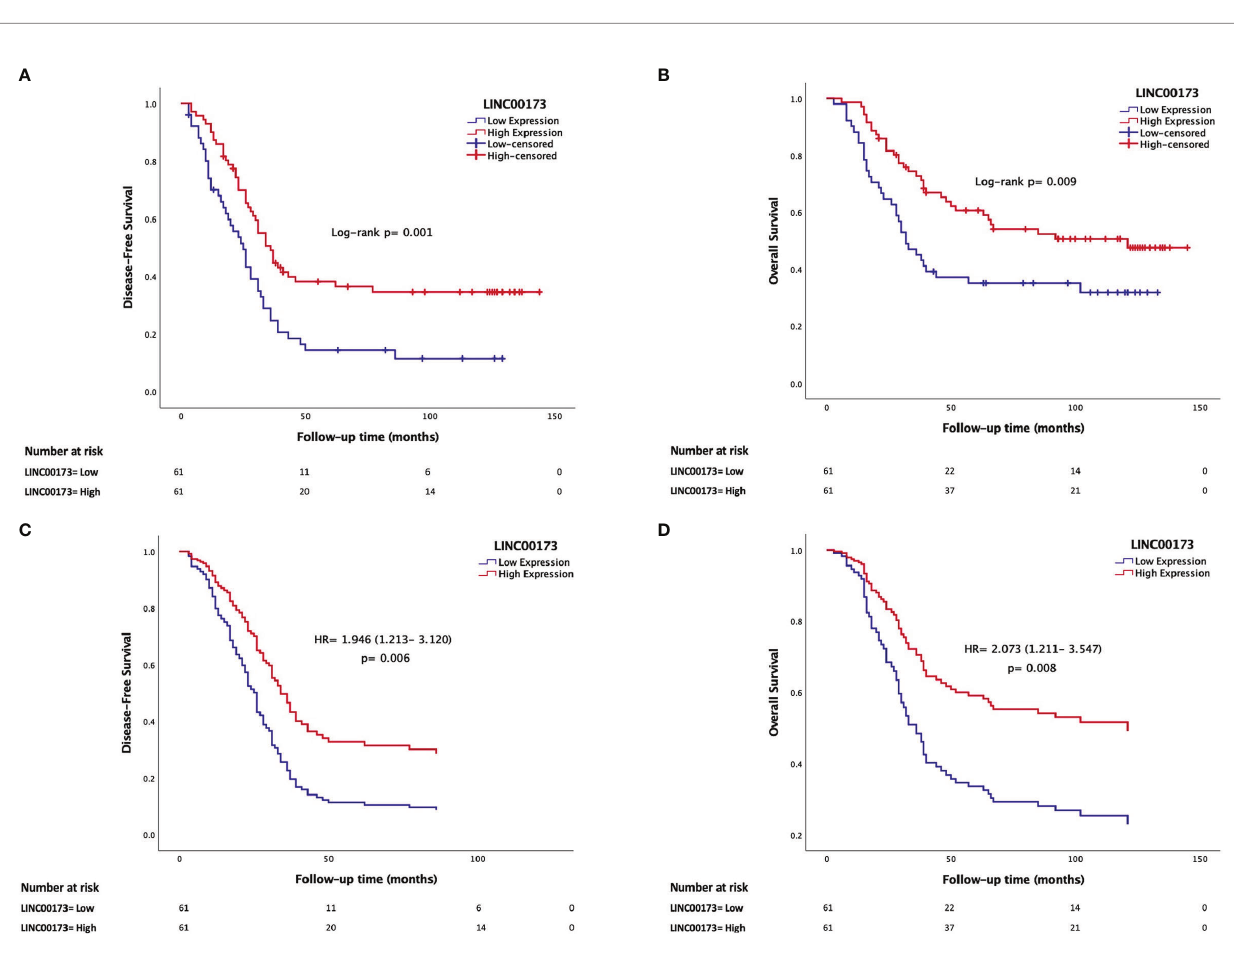
FIGURE 4 | Underexpression of LINC00173 is a maker for poor prognosis in B-cell precursor acute lymphoblastic leukemia patients. (A) Low expression of LINC00173 is associated with decreased disease-free survival (Kaplan – Meier) and (B) poor overall survival (Kaplan – Meier), (C) higher risk of relapse (Cox regression), and (D) death (Cox regression). TARGET cohort data.